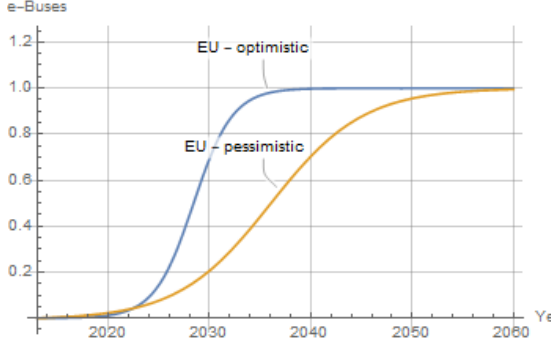
Figure 6. The cumulative Bass curves for Spain, the United Kingdom, Norway, and Turkey [own study].